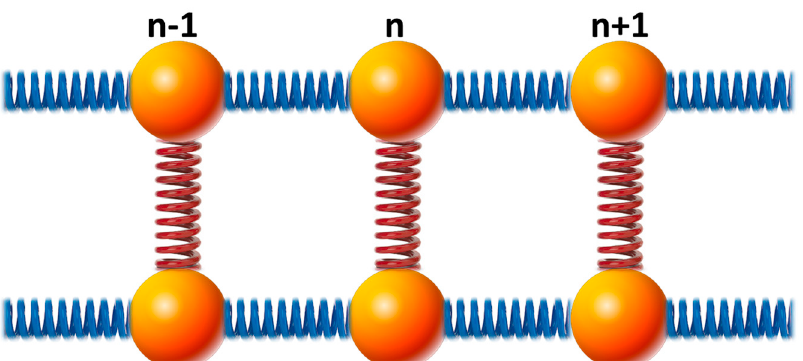
Figure 1. Schematic illustration of the phononic structure composed of two coupled 1-D harmonic crystals. The atoms in the lower and upper 1-D harmonic crystals have mass m and M , respectively. The force constant of the springs of each 1-D harmonic crystal is taken to be the same, K 0 . The force constant of the coupling springs is K I . The periodicity of the crystal is a .